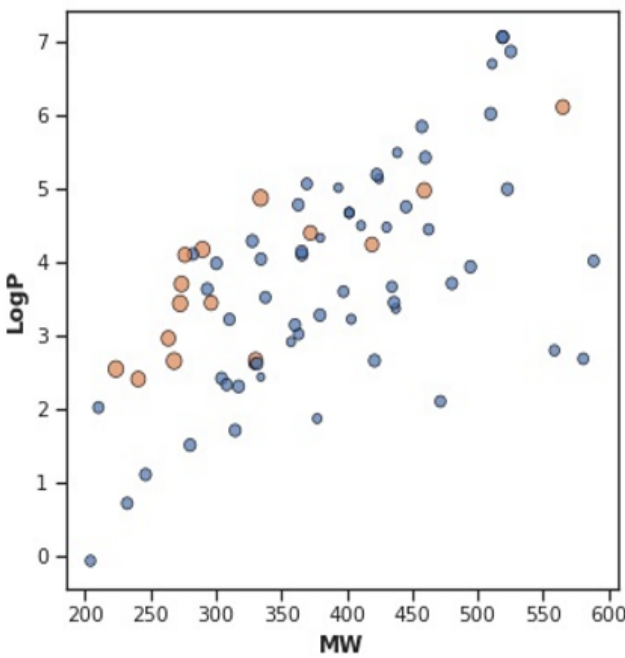
Figure 8. Scatter plot of MW vs. LogP .